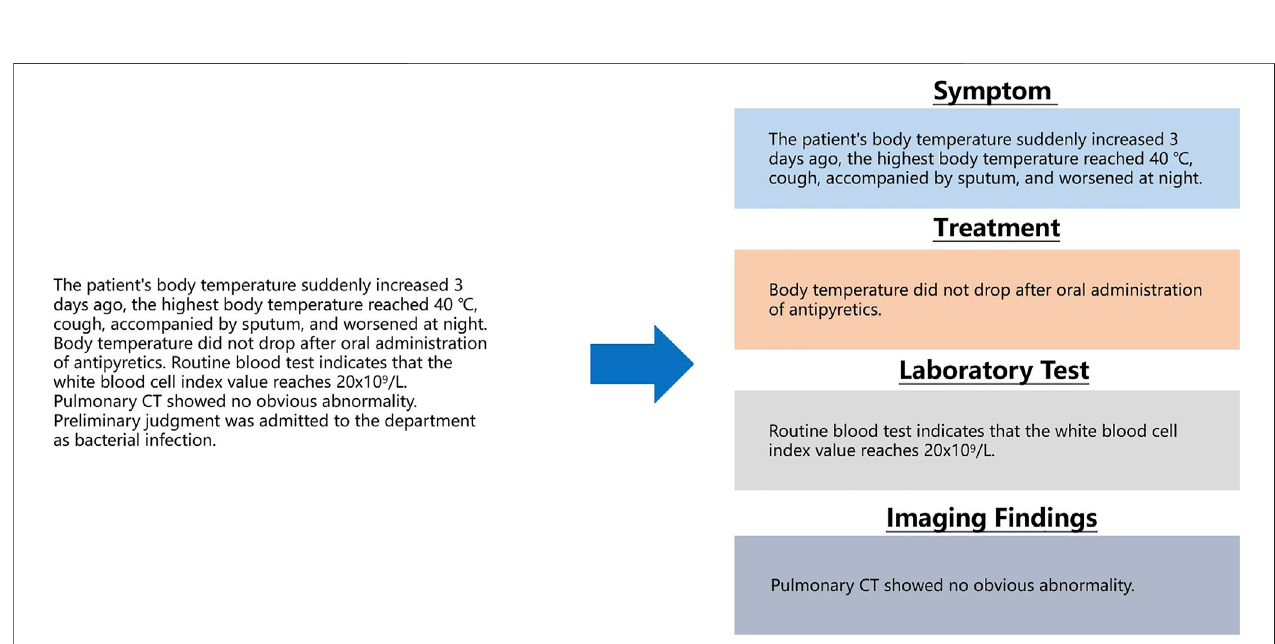
FIGURE 3 | Classify sentences in clinical record text into correct